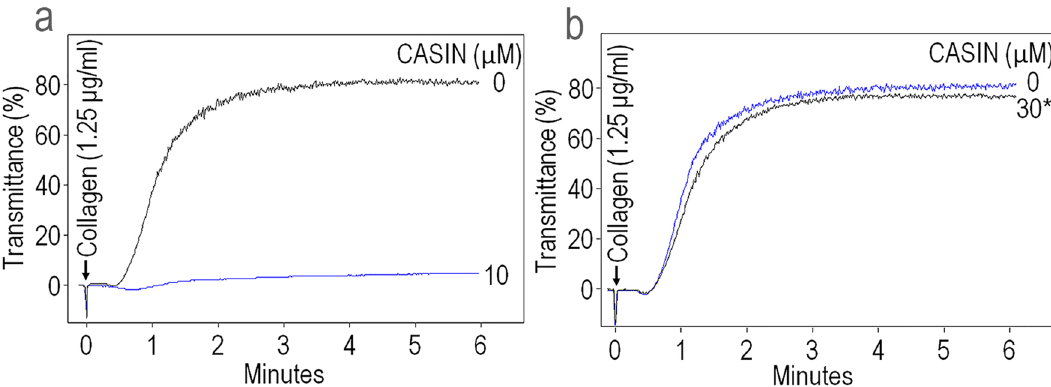
Figure 3. CASIN is a reversible inhibitor of platelet activation. ( a ) Addition of CASIN (10 M µ ) to washed human platelets two minutes before stimulation with collagen blocked platelet aggregation. ( b ) Human platelets were incubated with CASIN (30 µM) for 30 min at 37 °C and then washed to remove CASIN prior to addition of collagen. Removal of CASIN restored collagen induced aggregation. The aggregation tracings are representative of four independent